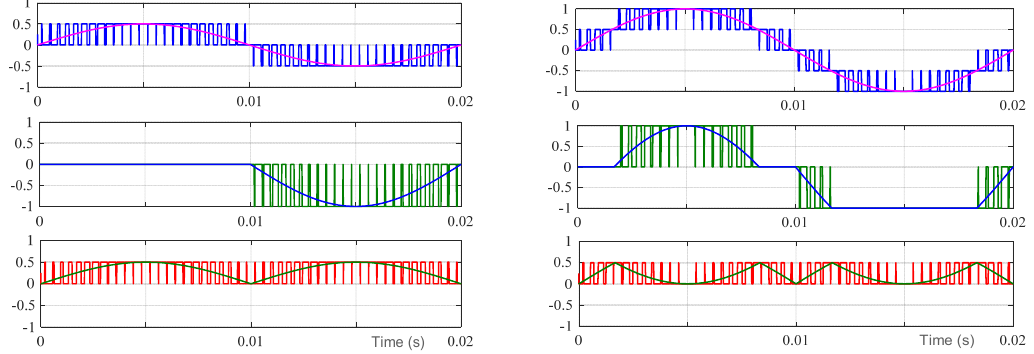
Figure 3. Simulation results ( f sw = 2.5 kHz): modulating signals and instantaneous output voltages normalized by V : total ( top ), H-bridge ( middle ), and LDN ( bottom ) in the case of m = 0.5 ( left ) and m = 1 ( right ).